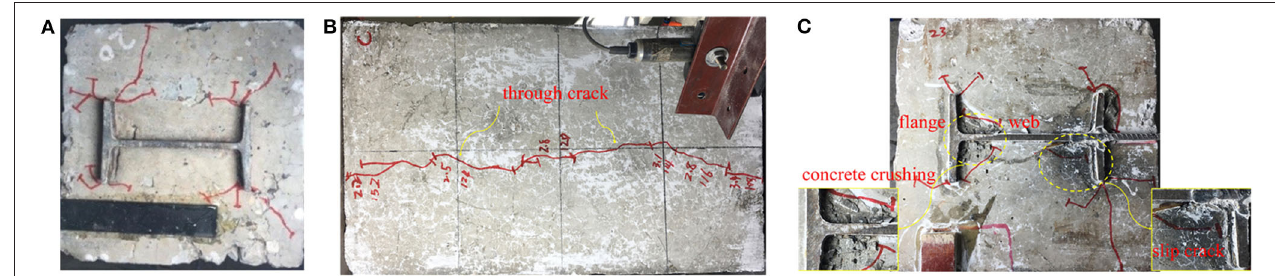
FIGURE 6 | Typical crack form of specimen: (A) loading end; (B) lateral; (C) free